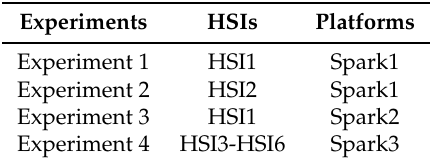
Table 1. Details about the four